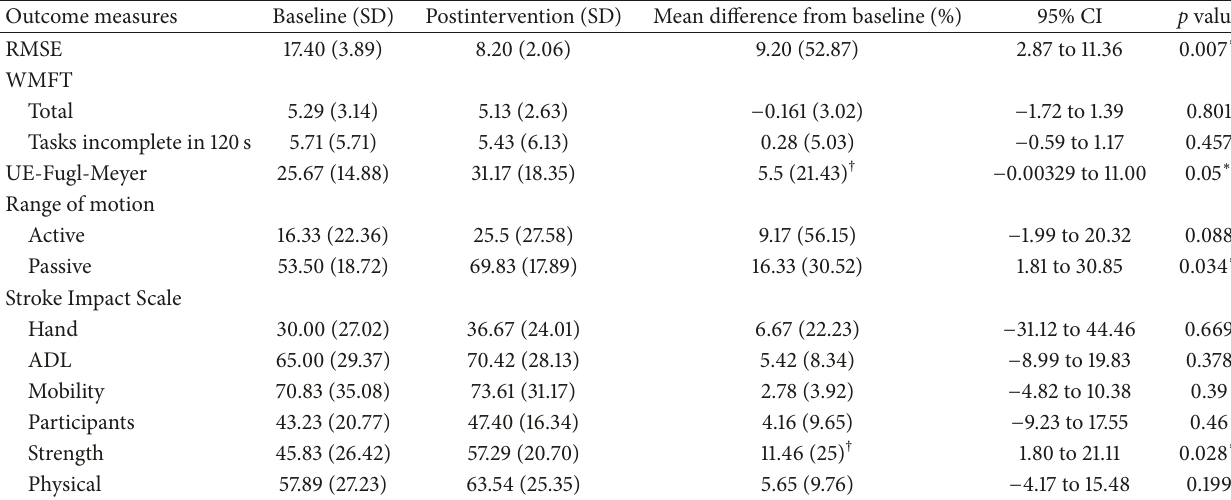
Table 2: Clinical Outcome Measures.